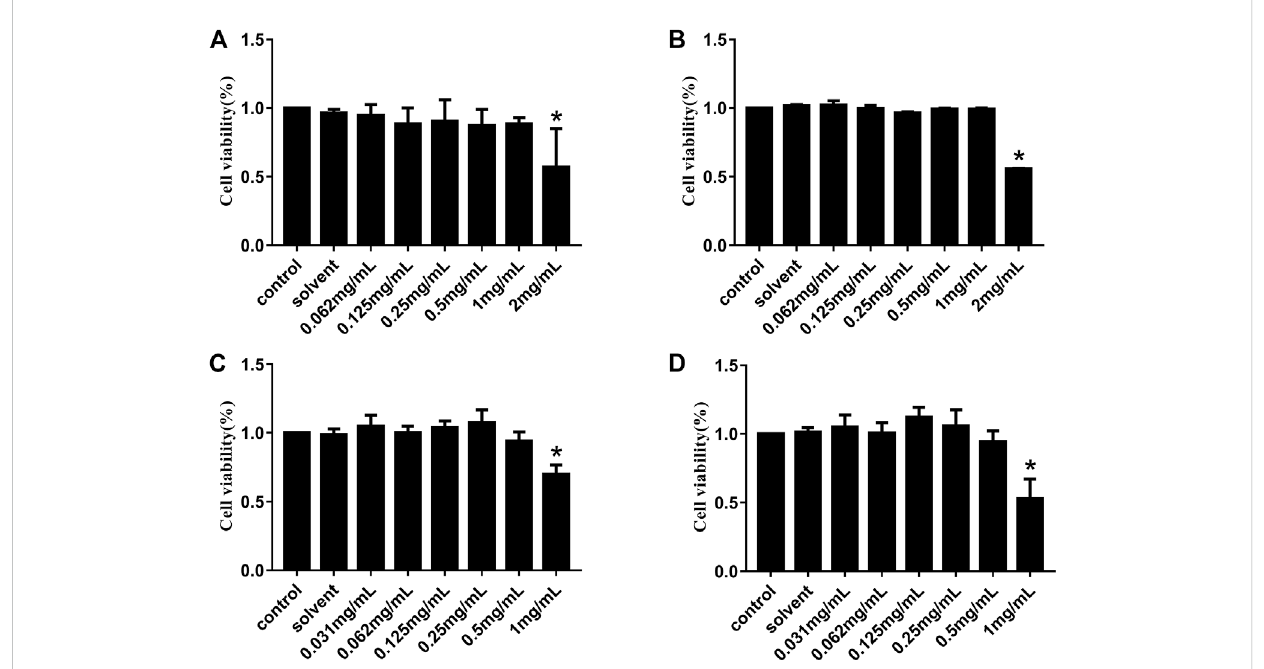
FIGURE 1 Cytotoxicity of HJ to Vero andIPI-FXcells invitro . Viabilityof Vero cellstreatedwithdifferentconcentrationsof HJ (0.062 – 2 mg/mL)for 24 h (A) and48 h (B) , and the viability of IPI-FX cells treated with different concentrations of HJ (0.031 – 1 mg/mL) for 24 h (C) and 48 h (D) were measured by CCK-8 method. Meanwhile, the control normal DMEM or solvent DMEM with sterile water for 24 h and 48 h were detected. Results are representative of three independent experiments. Data are represented as mean ± SD, n = 3. *, and p < 0.05 was considered statistically signi fi cant compared with the control group.